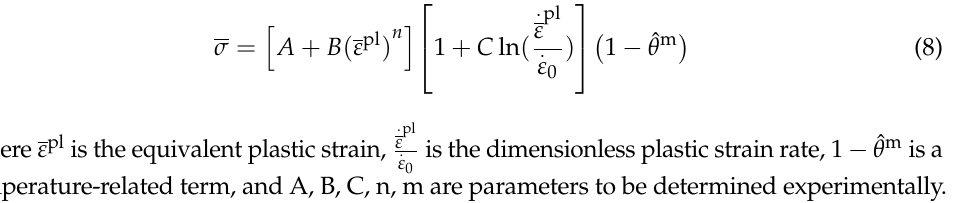
Table 1. Mechanical parameters of X80 pipeline steel.